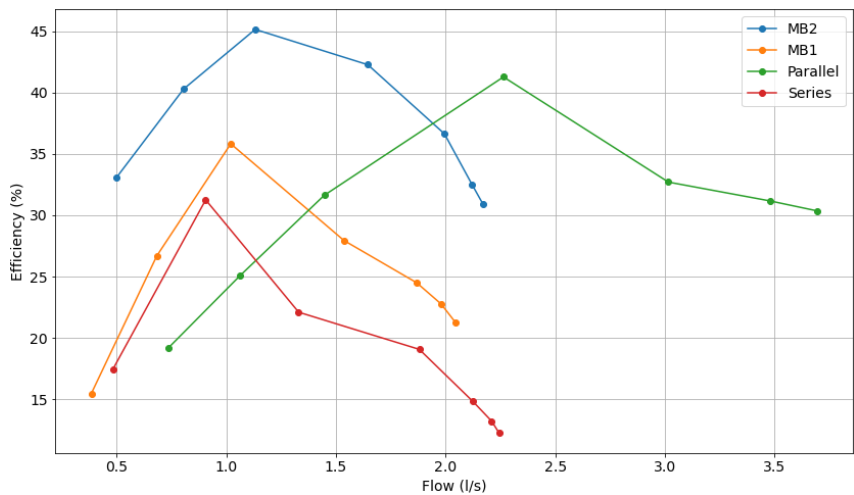
Figure 12. Comparative characteristic curve of the energy efficiencies of pumps operating at 30 Hz.